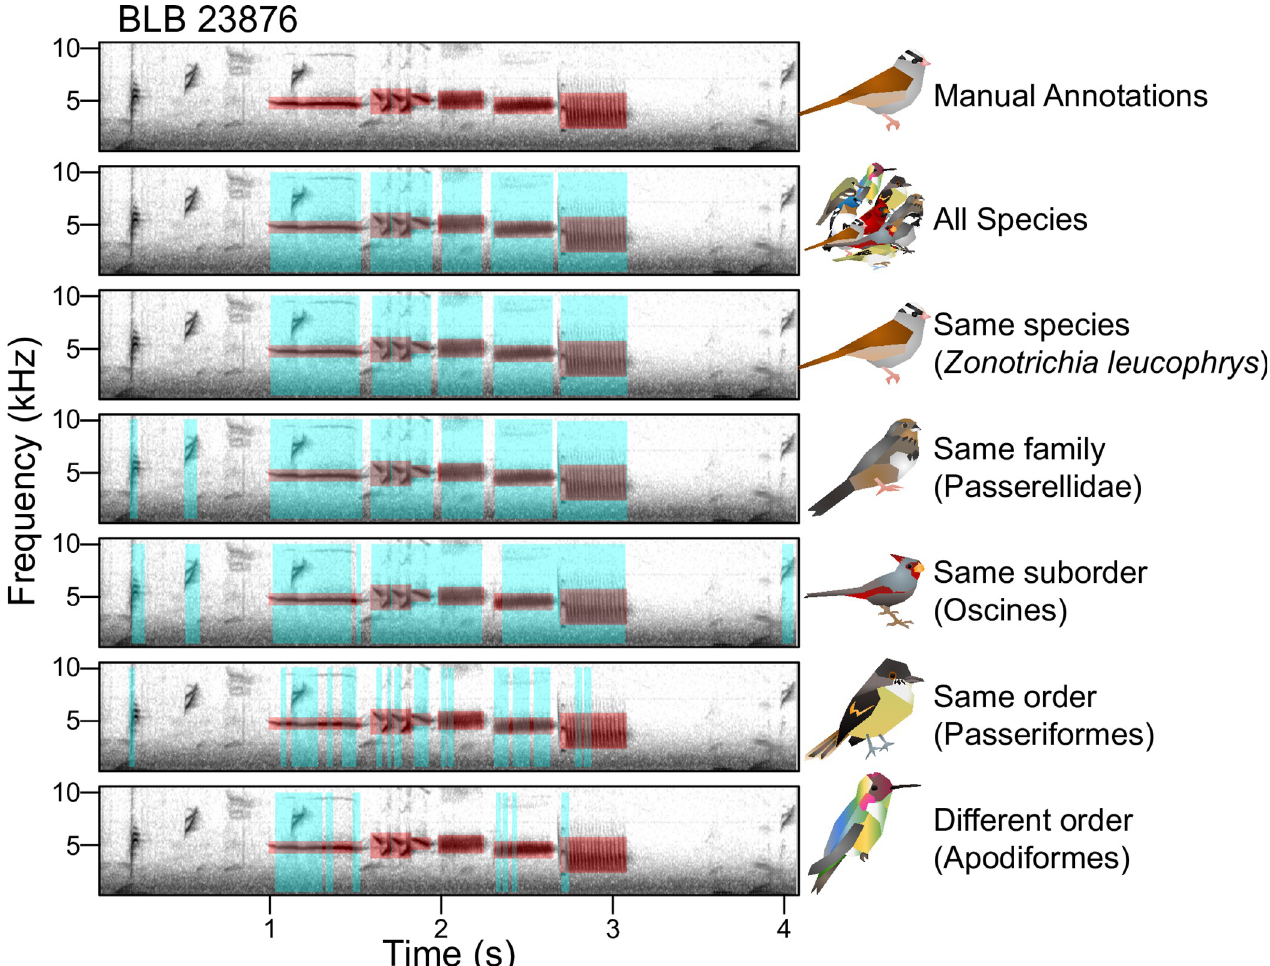
Fig 8. Performance of models on the same data vary between training species. Spectrogram depicts recording of Zonotrichia leucophrys BLB 23876, with time (seconds) on the x-axis and frequency (kHz) on the y-axis. Top row: the seven manual annotations used as the “true” segmentation in red; note the third through fifth syllable are separated by very small gaps and that there are notes from other species unlabeled as background noise. The following rows from top to bottom are predictions output from models trained on all species (9 Species Balanced), the same species ( Zonotrichia leucophrys ), another species from the same family ( Melozone fusca ), another species from the same suborder ( Cardinalis sinuatus ), another species from the same order ( Myiarchus tuberculifer ), and finally a species from a completely different order ( Calypte anna ). Predictions are given in blue with “true” values superimposed in